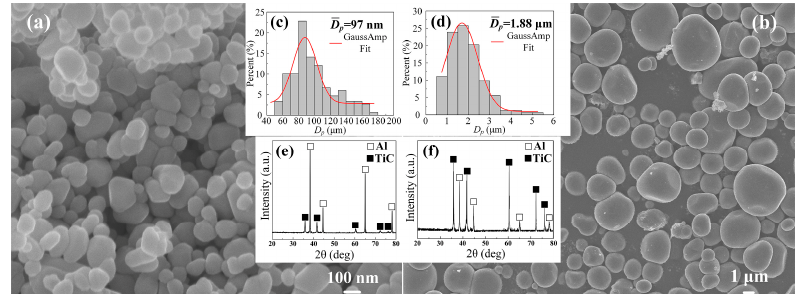
Figure 1. Morphologies and sizes of the TiC p formed in the SHS reaction systems of ( a ) 70Al-Ti-carbon nanotubes and ( b ) 30Al-Ti-carbon black, ( c , d ) the corresponding statistical results of the diameters of the TiC p in ( a , b ), respectively, ( e , f ) the XRD patterns of the nano-sized TiC p -Al master alloy and micro-sized TiC p -Al master alloy, respectively.